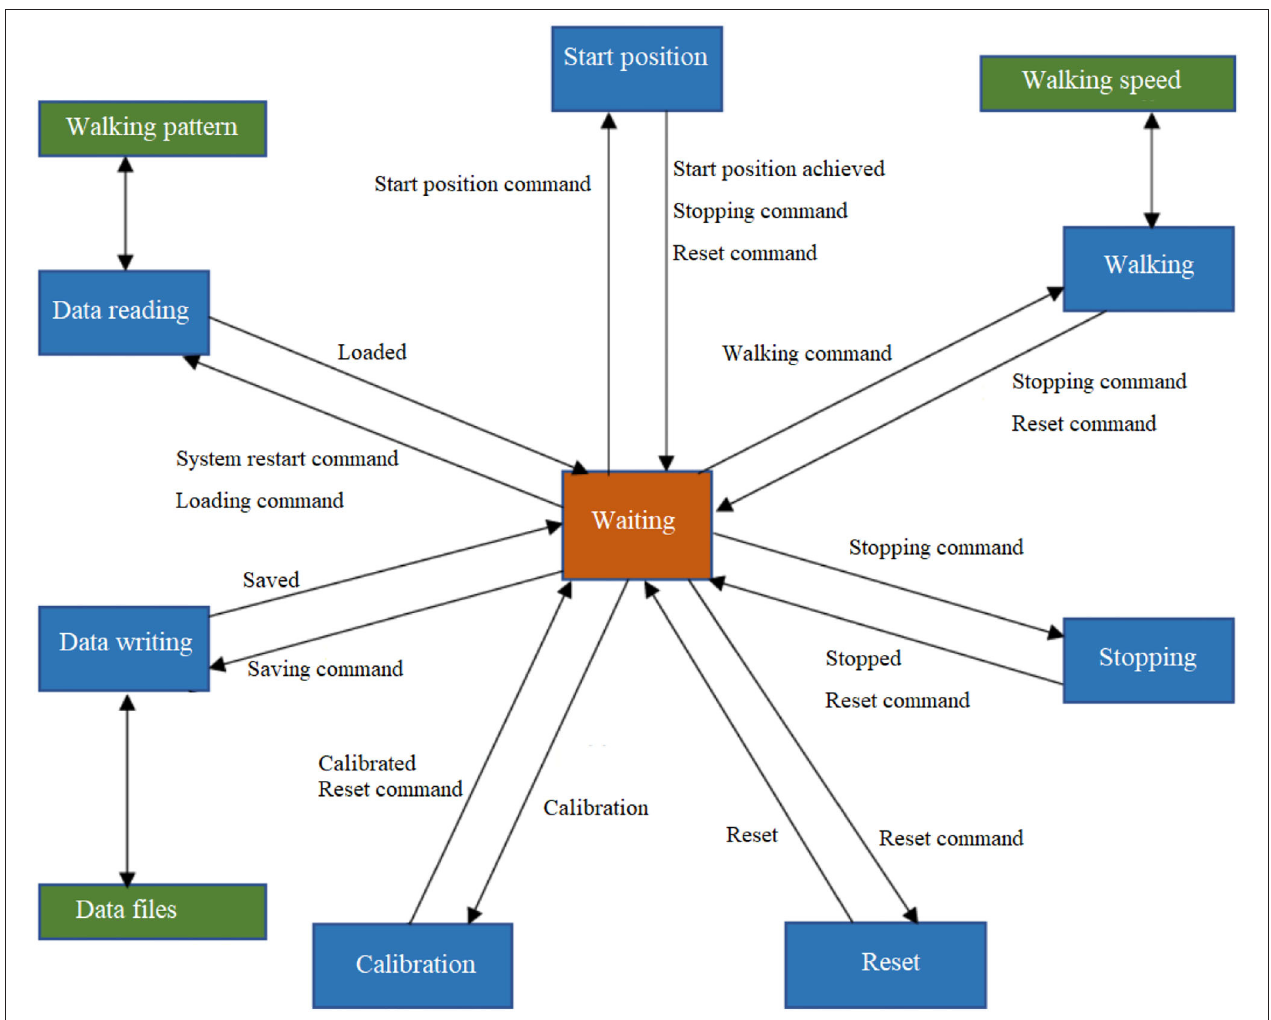
FIGURE 3 | The control functions using state machine